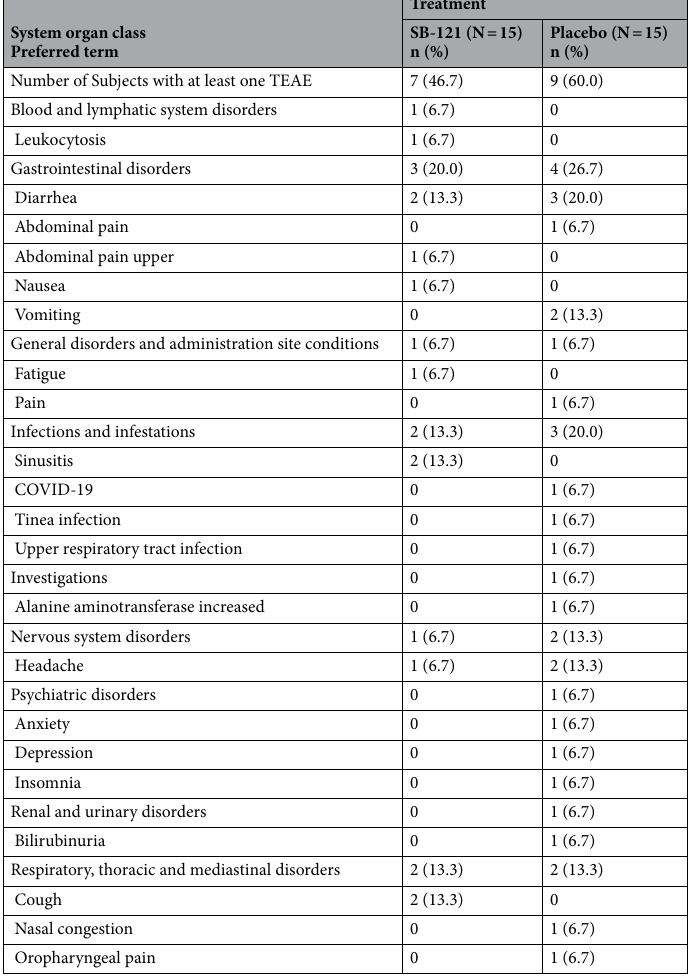
Table 2. Treatment-emergent adverse events (TEAEs).